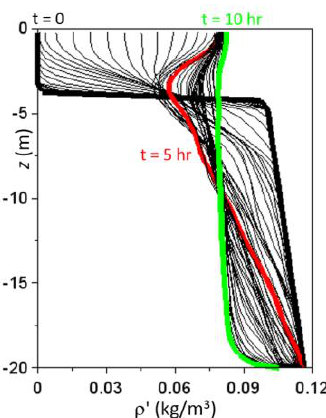
Figure 13. Scenario C with τ x = −0.1 Pa and Δ ρ = 0.1 kg/m 3 . Shown are density distributions after ( a ) 1.8 h; ( b ) 5 h; and ( c ) 10 h of simulation. Small arrows indicate the propagation direction of internal waves. See GIF Animation S4 for a simulation of this experiment.